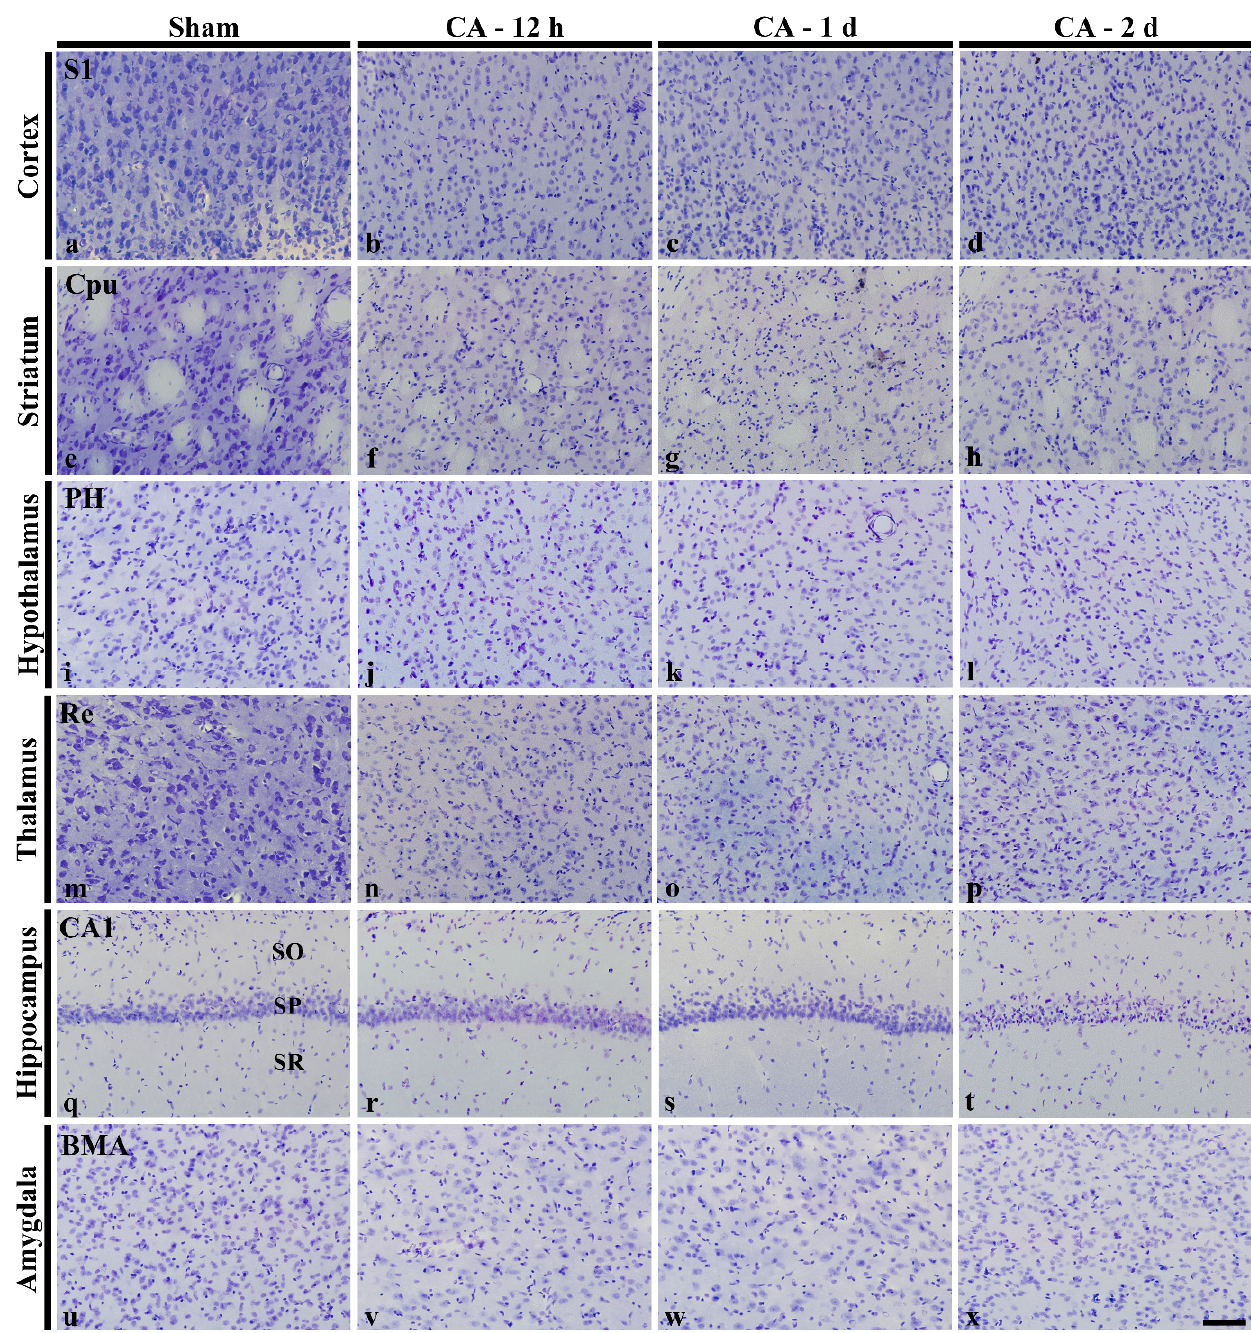
Figure 1. Cresyl Violet (CV) staining in main regions of the rat brain of the sham operated ( a,e,i,m,q,u ), and CA operated ( b – d , f – h , j – l , n – p , r – t , v – x ) groups. CV stainability is gradually pale (damaged) with time in the CA groups. Note that damage is distinct at 2 days after CA. BMA, basomedial amygdaloid nucleus; CA1, cornu ammonis 1; Cpu, caudate putamen; PH, posterior hypothalamic area; Re, reuniens thalamic nucleus; S1, primary somatosensory cortex; SO, stratum oriens; SP, stratum pyramidale; SR, stratum radiatum. Scale bar: 100 μ m.